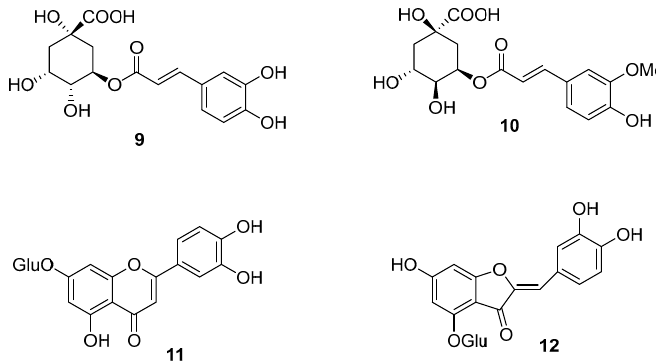
Figure 3. Phenolics identified from Oxalis pes-caprae [36]. Chlorogenic acid 9 , quinic ferrulate 10 , luteolin glucoside 11 and cernuoside 12 .